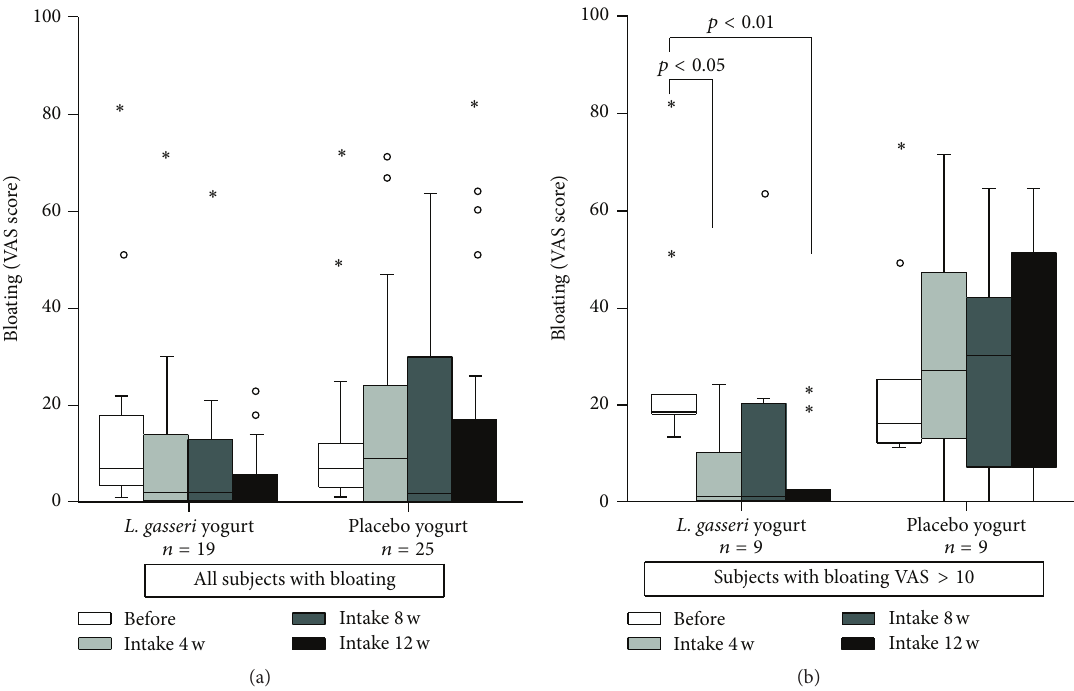
Figure 2: Changes in the bloating severity score. Participants were asked to take Lactobacillus gasseri OLL2716-containing yogurt or placebo yogurt (control) once daily for 12 weeks and the severity of dyspeptic symptoms was analyzed according to a visual analogue scale (VAS) as follows: 1, no symptoms; 10, severe pain, never experienced before. (a) The total number of participants with bloating; (b) the number of participants with a bloating severity score of > 10. ∘ : less than 3 times the height of the box. ∗ : more than 1.5 times the height of the box.